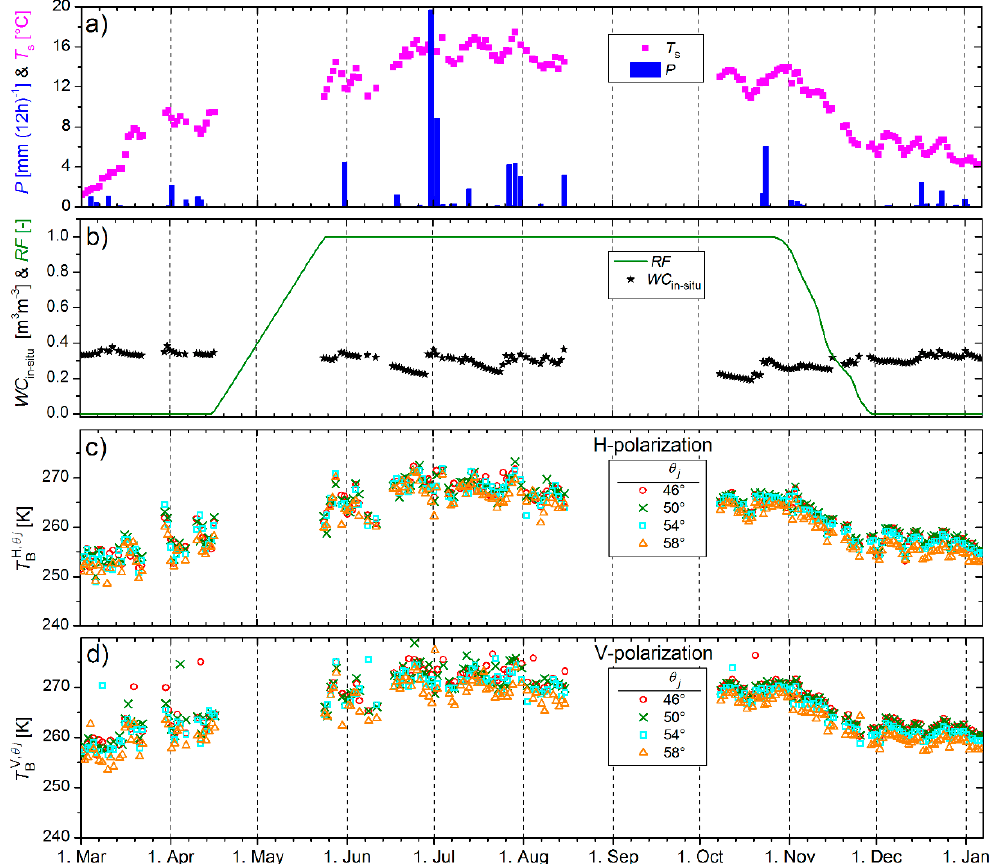
Figure 3. Time series of experimental data measured during FOSMEX [8]. ( a ) In-situ soil temperature T s (magenta squares), and precipitation P (blue columns); ( b ) Relative Foliation RF of the forest canopy (green line), and forests soil liquid water content WC in − situ (black stars). L-band T θ j = { 46 ◦ ,50 ◦ , 54 ◦ , 58 ◦ } and p = { H,V } are shown in ( c , d ), respectively.